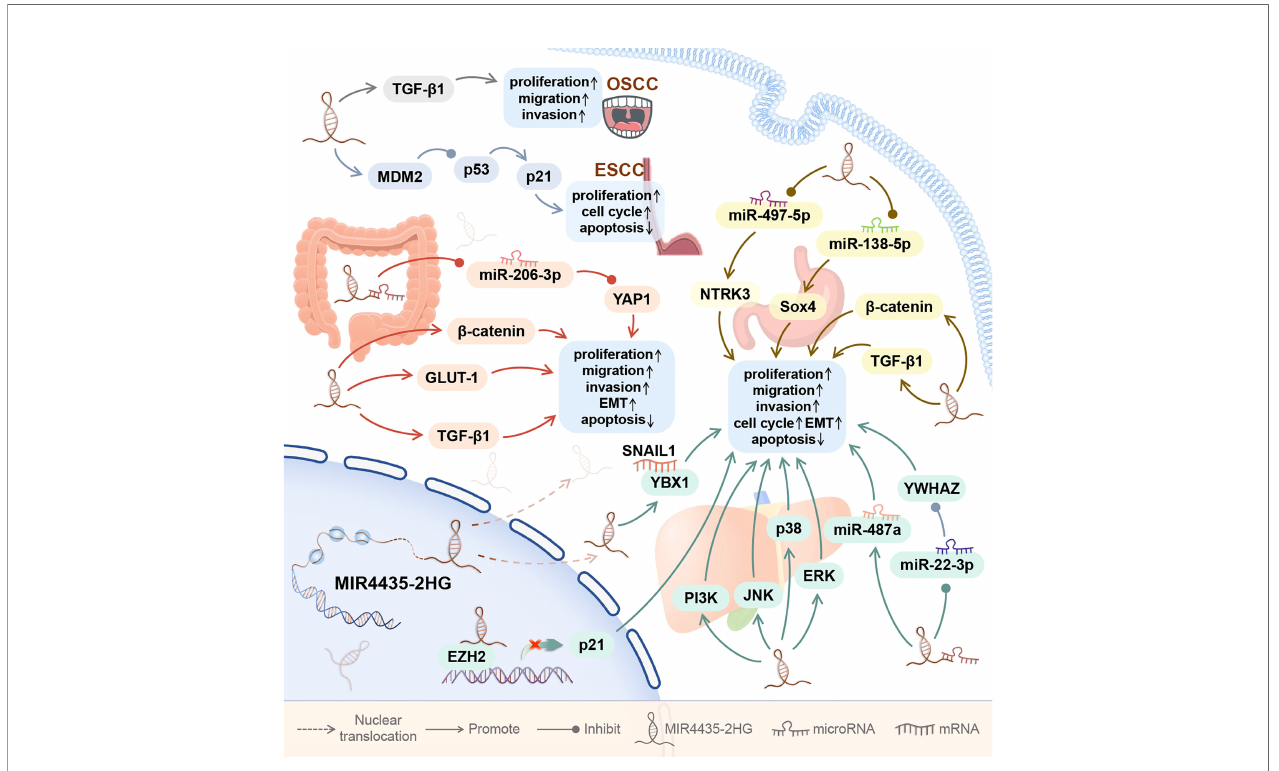
FIGURE 2 | The role of MIR4435-2HG in digestive system cancer. In the digestive system, MIR4435-2HG can promote the growth of 5 types of tumors, including oral squamous cell carcinoma (OSCC), esophageal squamous cell carcinoma (ESCC), hepatocellular carcinoma (HCC), gastric cancer (GC), and colorectal cancer (CRC). By regulating downstream genes, MIR4435-2HG can affect tumor cell proliferation, migration, invasion, apoptosis, EMT, and cell